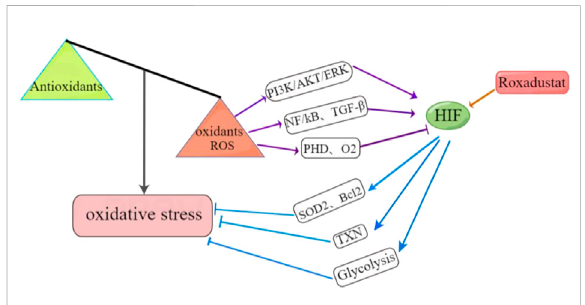
FIGURE 4 Roxadustat reducesoxidativestressbyupregulatingHIF.Left: Oxidative stress occurs when there is an imbalance between oxidative and antioxidative reactions. Bottom-Right: Roxadustat upregulates HIF, which reduces oxidative stress by upregulating two target genes (SOD2, Bcl2), glycolysis, and thioredoxin (TXN). Top-Right: ROS overproduction also increases HIF activity by upregulating the PI3K/AKT/ERK pathway, activates the NF/kB and TGF- β signaling pathways, and promotes the expression of HIF. Conversely, ROS can also reduce the HIF level by upregulating PHD enzymes or supplying excess